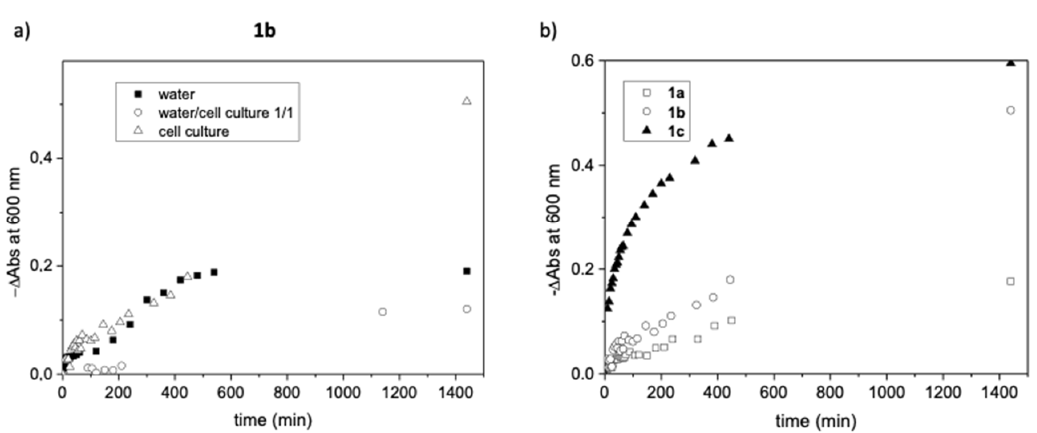
Figure 4. SEM images for 3b ( a ) 0.5 mM in water; ( b ) 0.7 mM in 1 / 1 water / bacterial cell culture medium; and ( c ) 0.7 mM in the bacterial cell culture medium.